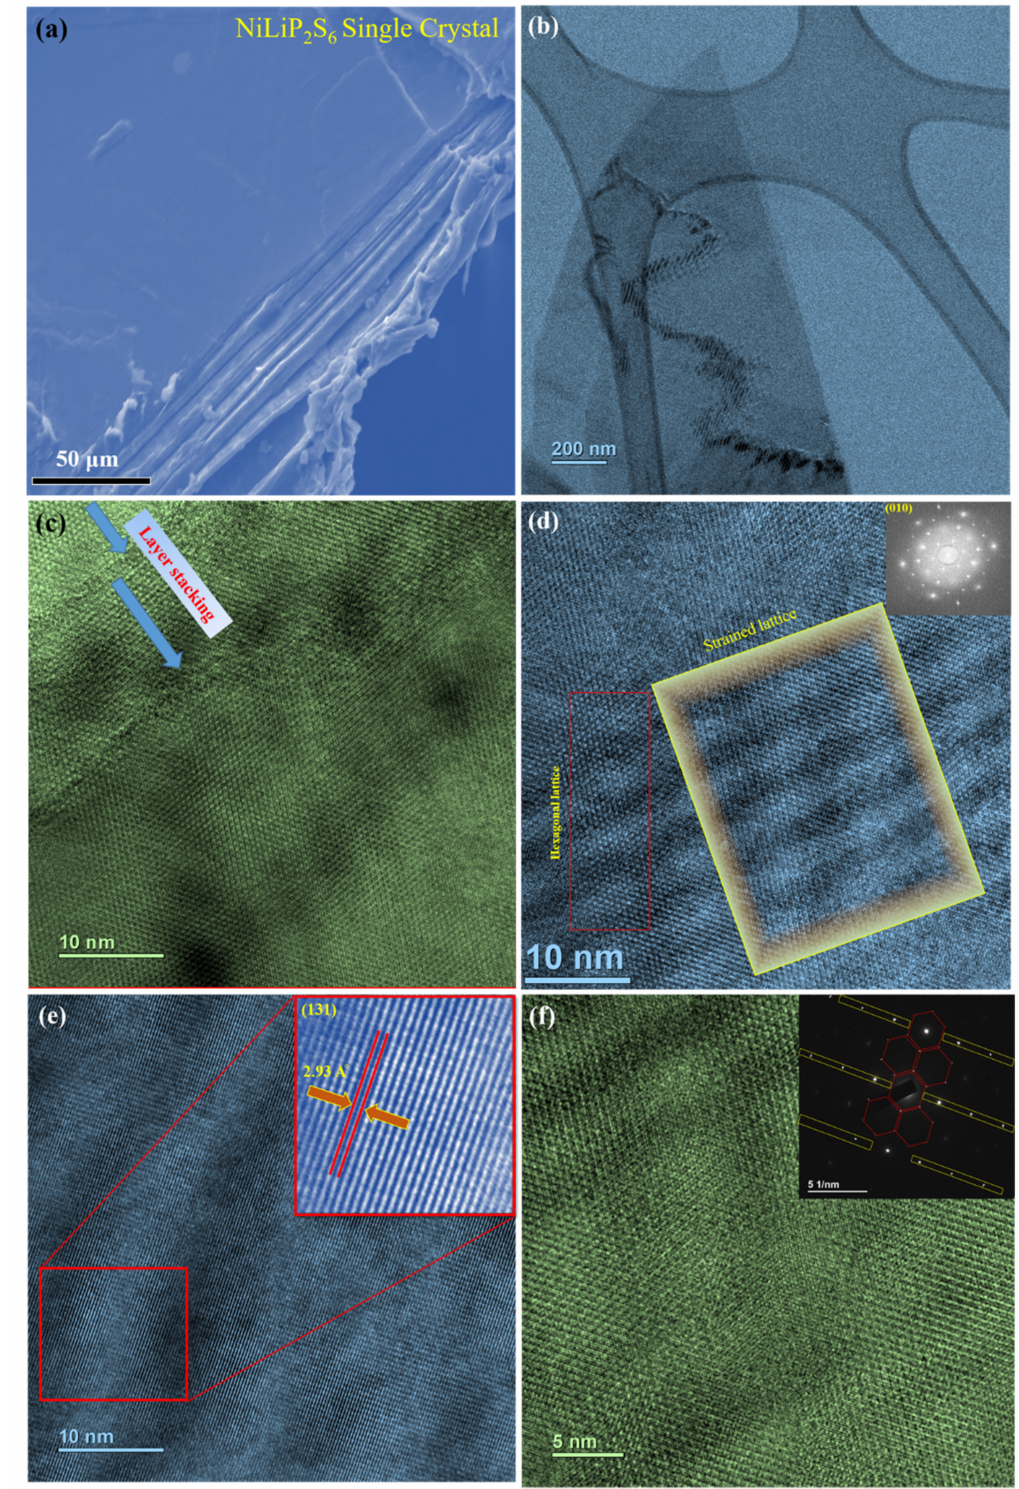
Figure 2. Scanning and Transmission Electron Microscopy images of NLPS: ( a ) SEM image of layered Single crystal. ( b ) HRTEM image of cleaved thin layer single crystal. ( c ) HRTEM image exhibiting layered stacking of single crystal. ( d ) HRTEM image displaying strain lattice with top-right inset shows a hexagonal pattern. ( e ) Inset at the upper right corner shows d-spacing between atoms along with atoms arrangement. ( f ) Inset at the upper right corner shows SAED (selective area electron diffraction pattern) and super